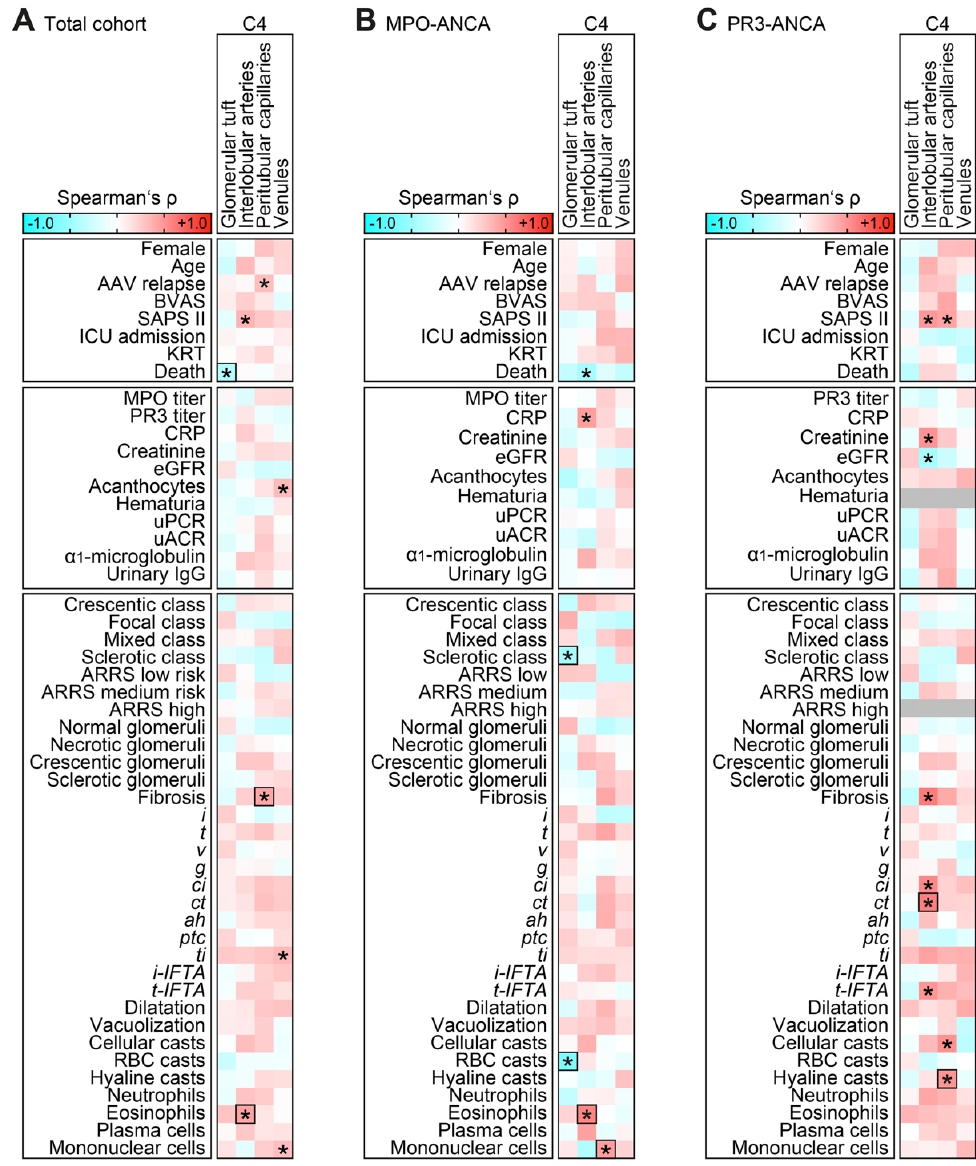
Figure 2. Complement C4 deposits associate with clinicopathological characteristics in ANCA- associated renal vasculitis. ( A – C ) Association between C4 deposits localized to the glomerular tuft, interlobular arteries, peritubular capillaries, and venules; clinicopathological characteristics are shown by heatmap reflecting mean values of Spearman’s ρ . Asterisks (*) indicate significant associations in the univariate analysis ( p < 0.05), rectangle boxes indicate significant associations in the stepwise regression analysis ( p < 0.05). The grey line for hematuria within the heatmap reflects no data analysis because the respective parameter was present in all cases; the grey line for ARRS high risk indicates that the respective parameter was absent in all cases.